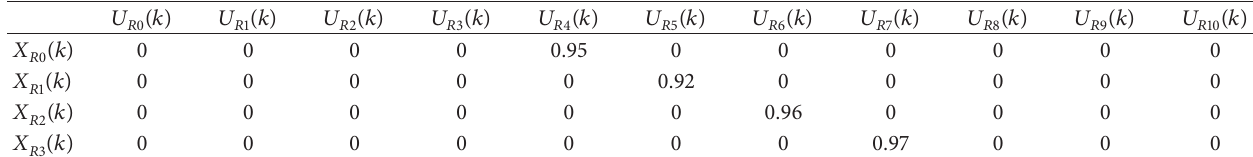
of the sensitivity of unconscious reaction. YM